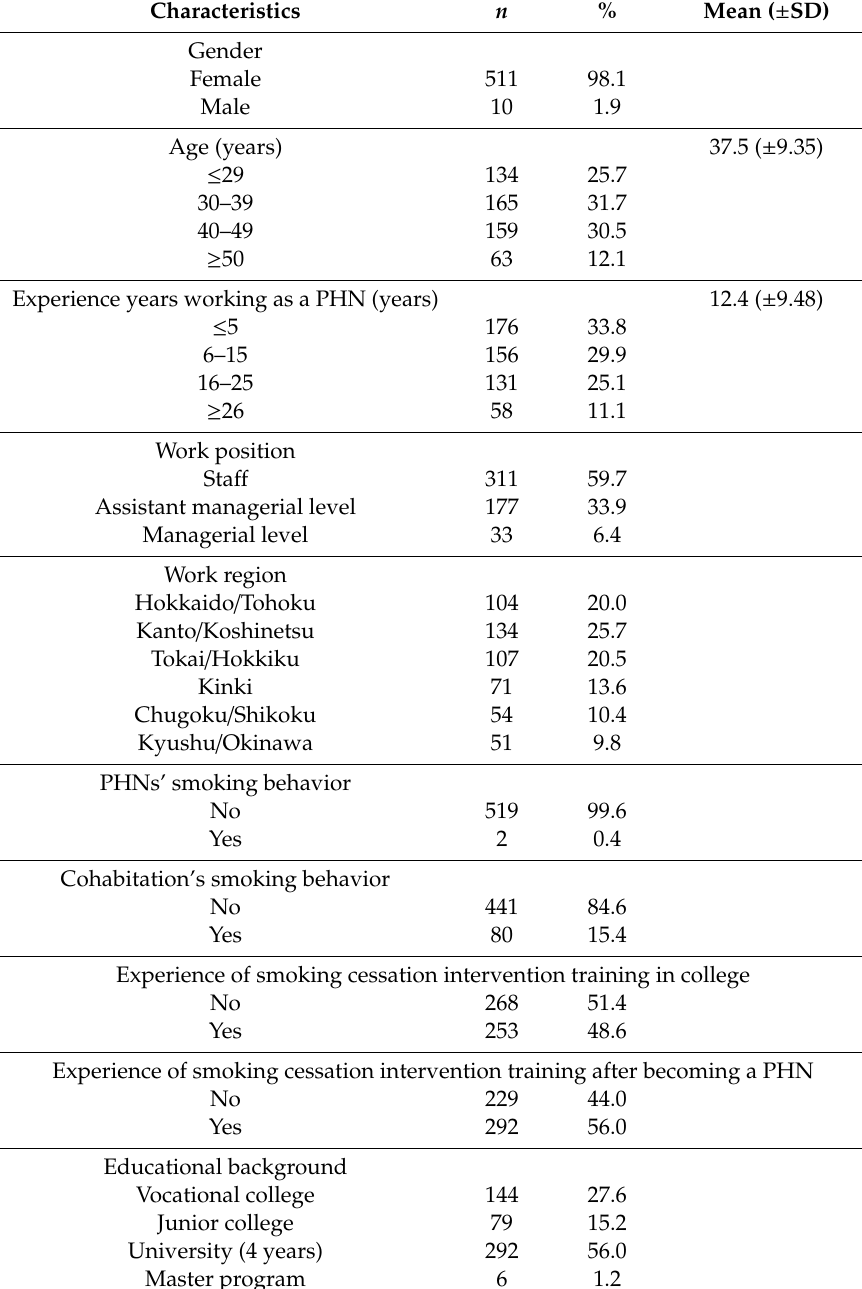
Table 1. Characteristics of respondents included in the analysis ( n =